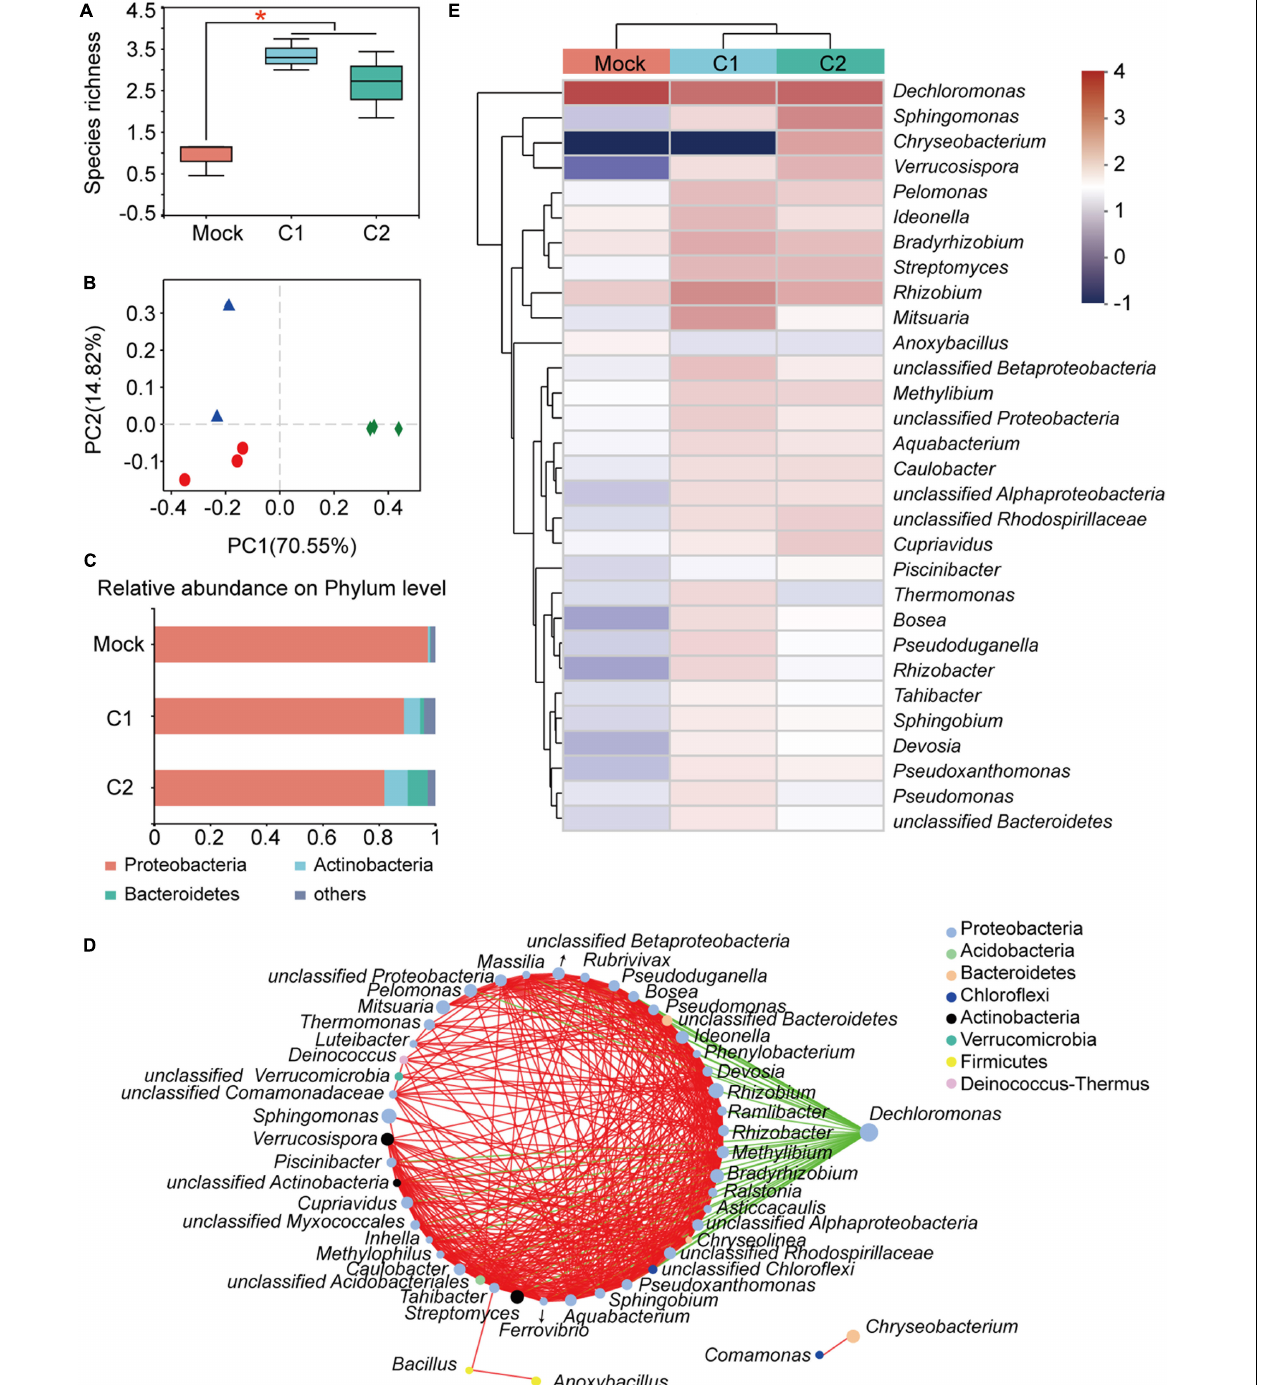
FIGURE 4 | Bacterial community of cotton roots 30 days after GN03 inoculation. (A) Boxplot of species richness (number of OTUs) by Shannon index. The asterisk (*) indicates a significant difference (one-way ANOVA, LSD post hoc test, p < 0.05, see Supplementary Table 5B ). (B) PCoA plot based on the structure of the microbial community. Each symbol represents a sample. Mock, green diamonds; C1, red circle; and C2, blue triangles. (C) Relative abundance of bacterial phyla in each group. Each value is the mean of three measurements. (D) Network correlation between plant root bacteria. The nodes on the left side of the ring are positively correlated at all instances (red lines) and the green lines indicate negative correlations between the genera. (E) Heatmap showing the relative abundance of the top 30 dominant taxa at the genus level in cotton roots.